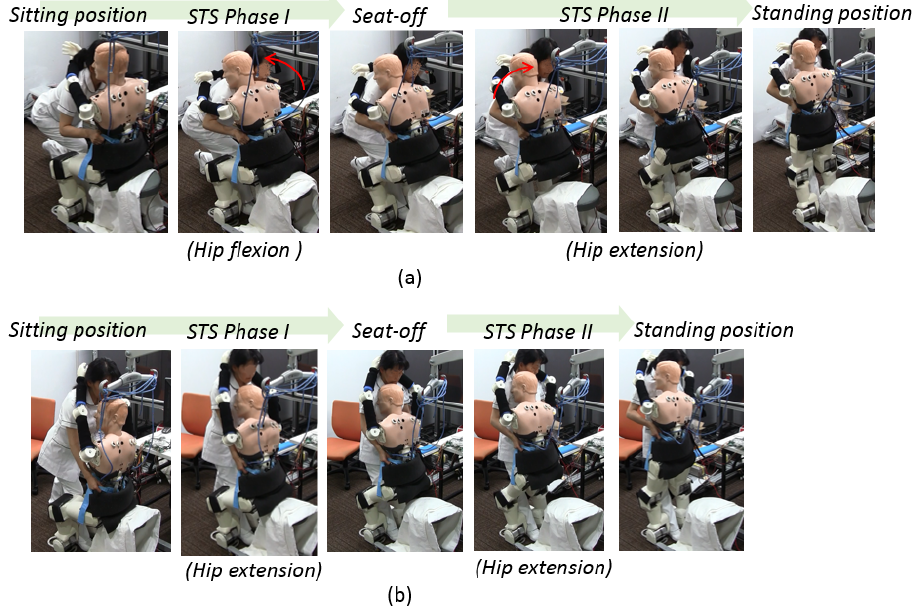
Figure 10. STS transfer skill performed by nursing teacher with ( a ) correct and ( b ) incorrect